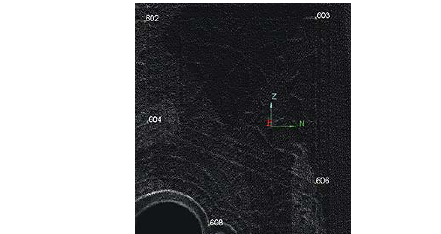
Figure 11. Orthophotograph (1 mm resolution) of the chapel floor. Some details of the tiled floor are shown.